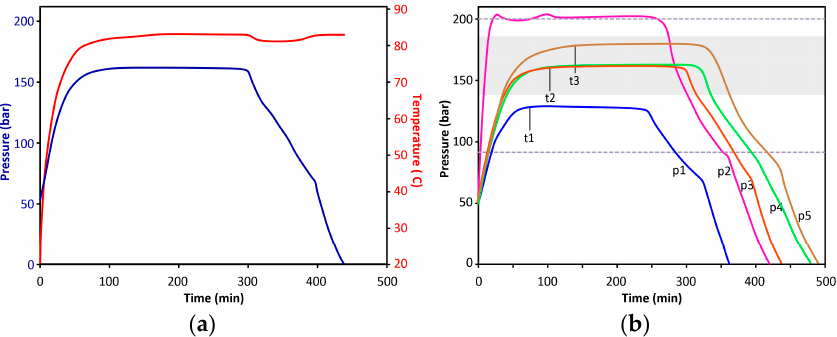
Figure 5. ( a ) Pressure and internal temperature diagrams of a typical supercritical drying process. Moderate internal temperature drop can be observed in the supercritical region of decompression; ( b ) Pressure diagrams of characteristic MT supercritical dryings. Grey area indicates preferred drying conditions, dashed lines show the lowest and highest pressure under which successful dryings were performed. (p1) Rapid drying with low gel load; (p2) Overcharged reactor, CO 2 was released as the pressure reached the upper limit; (p3–p5) Characteristic MT SC dryings with full gel loads.